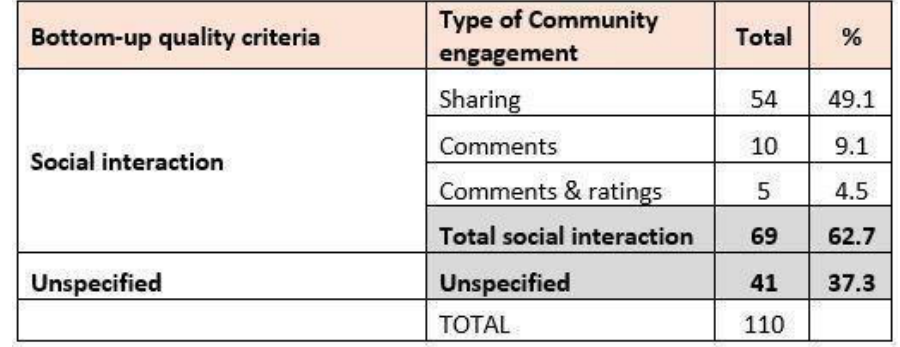
Community of Users (Bottom-Up Quality